Question: Identify the chart type used in this figure.
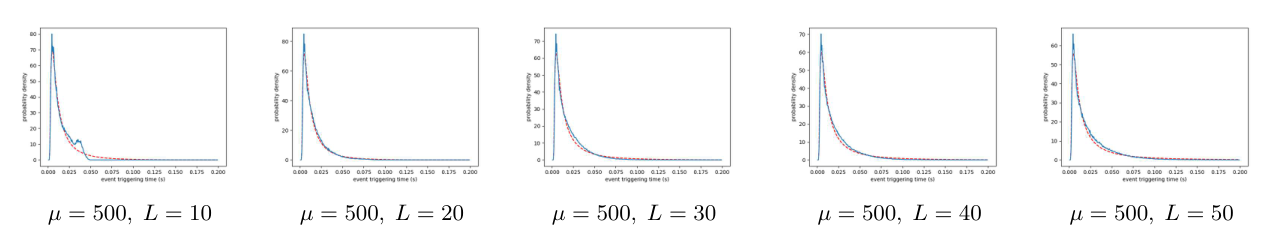
Answer: histogram